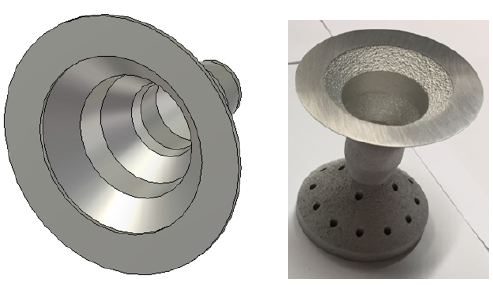
Figure 4. CAD model of the designed horn ( left ) and SLM prototype ( right